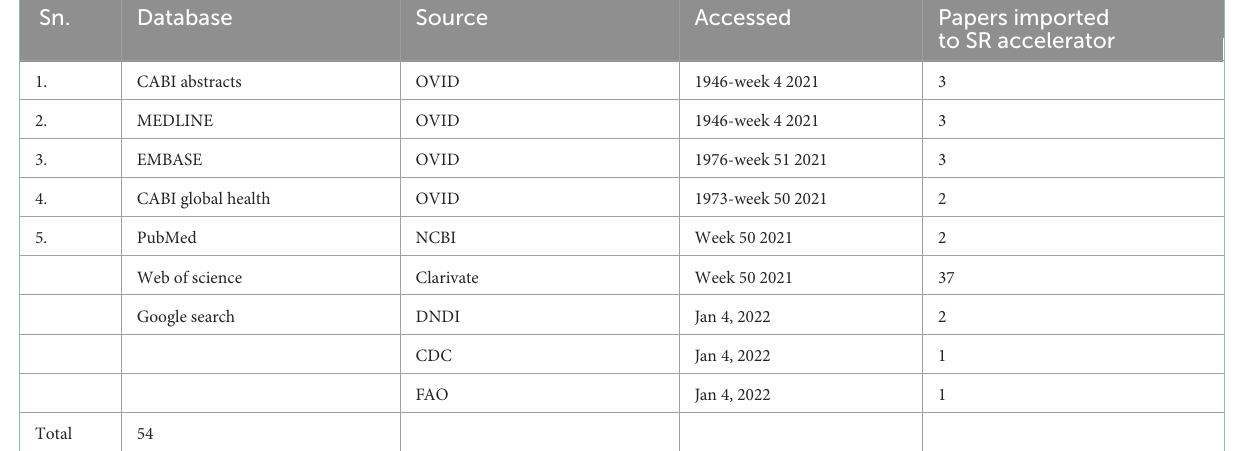
TABLE 1 Papers retrieved from the search of each database.